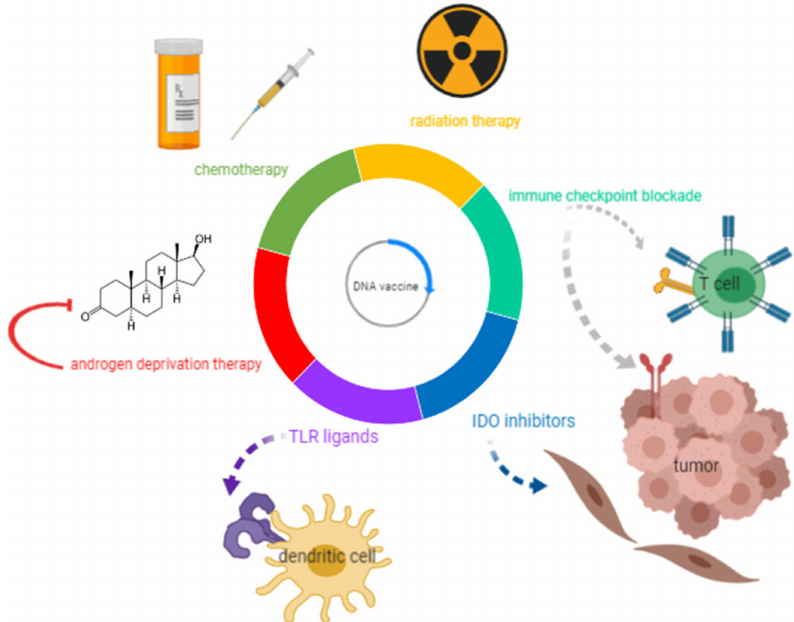
Figure 1. DNA vaccine combinations under evaluation as potential treatments for prostate